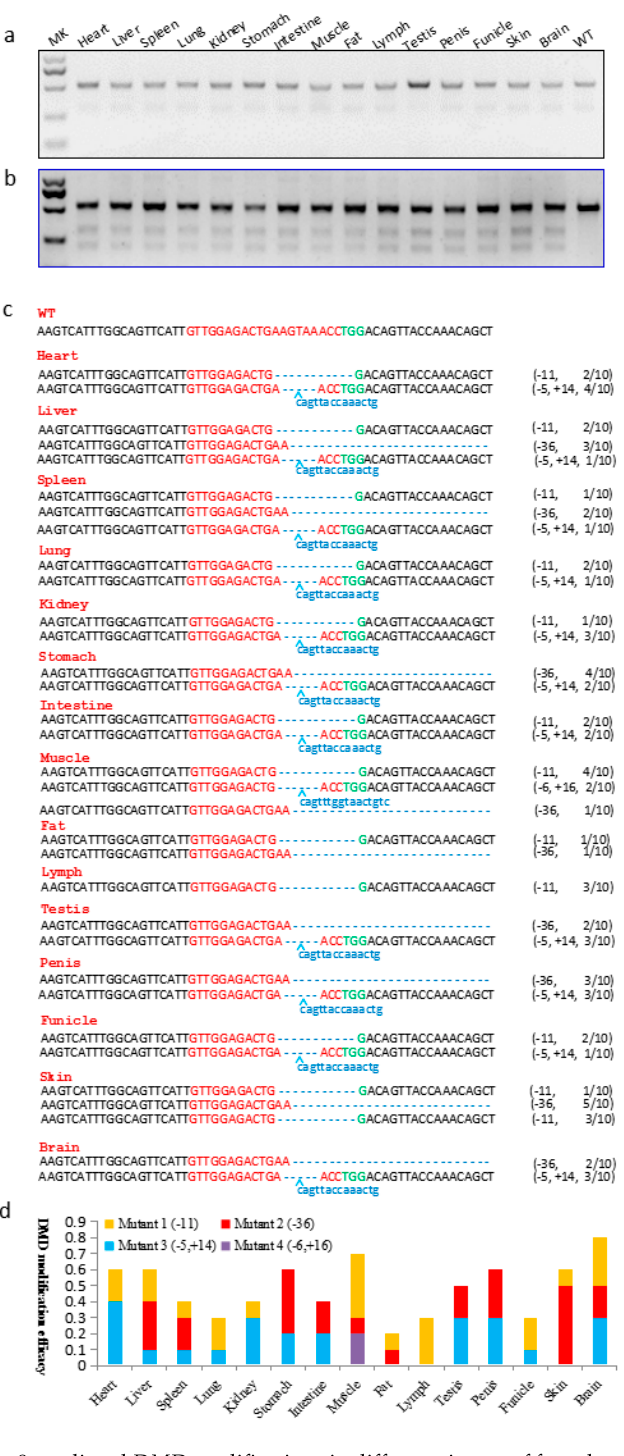
Figure 3. sgRNA:Cas9-mediated DMD modifications in different tissues of founder A. ( a ) PCR products of the DMD targeting region. WT, PCR product amplified from wild-type pig; ( b ) Detection of sgRNA:Cas9-mediated on-target cleavage of DMD by the T7EN1 cleavage assay; ( c ) Modified DMD sequences detected in founder A. WT, wild-type DNA sequence. Sequences complementary to sgRNA targeting site are labeled in red, and PAM sequences are in green; the mutations in blue, lower case indicates the inserted base, deletions ( − ), insertions (+); ( d ) sgRNA:Cas9-mediated DMD modification frequency in different founder A tissues. Mutant 1, 11 base pair deletion; Mutant 2, 36 base pair deletion; Mutant 3, five base pair deletion and 14 base pair insertion; Mutant 4, 6 base pair deletion and 16 base pair insertion.